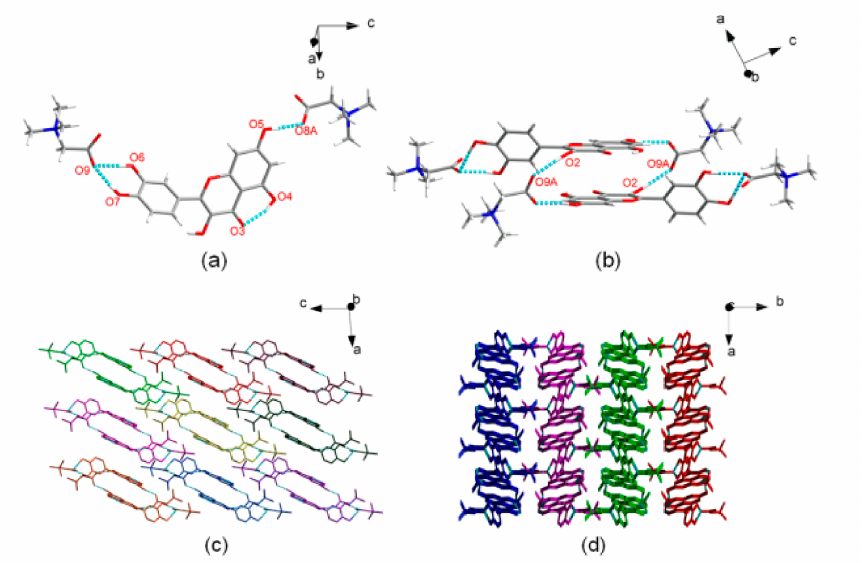
Figure 14. Crystal structure of QUE-BTN. ( a ) The asymmetric unit. ( b ) Two asymmetric units formed R 4 4 (24) dimeric structure. ( c ) 2D layered structure in the ac plane. Each dimeric structure in c is displayed in a different color. ( d ) 3D packing structure viewed along the c axis. In ( d ), adjacent molecular layers are displayed in different colors [71] (with permission from [71]; Copyright 2019 American Chemical